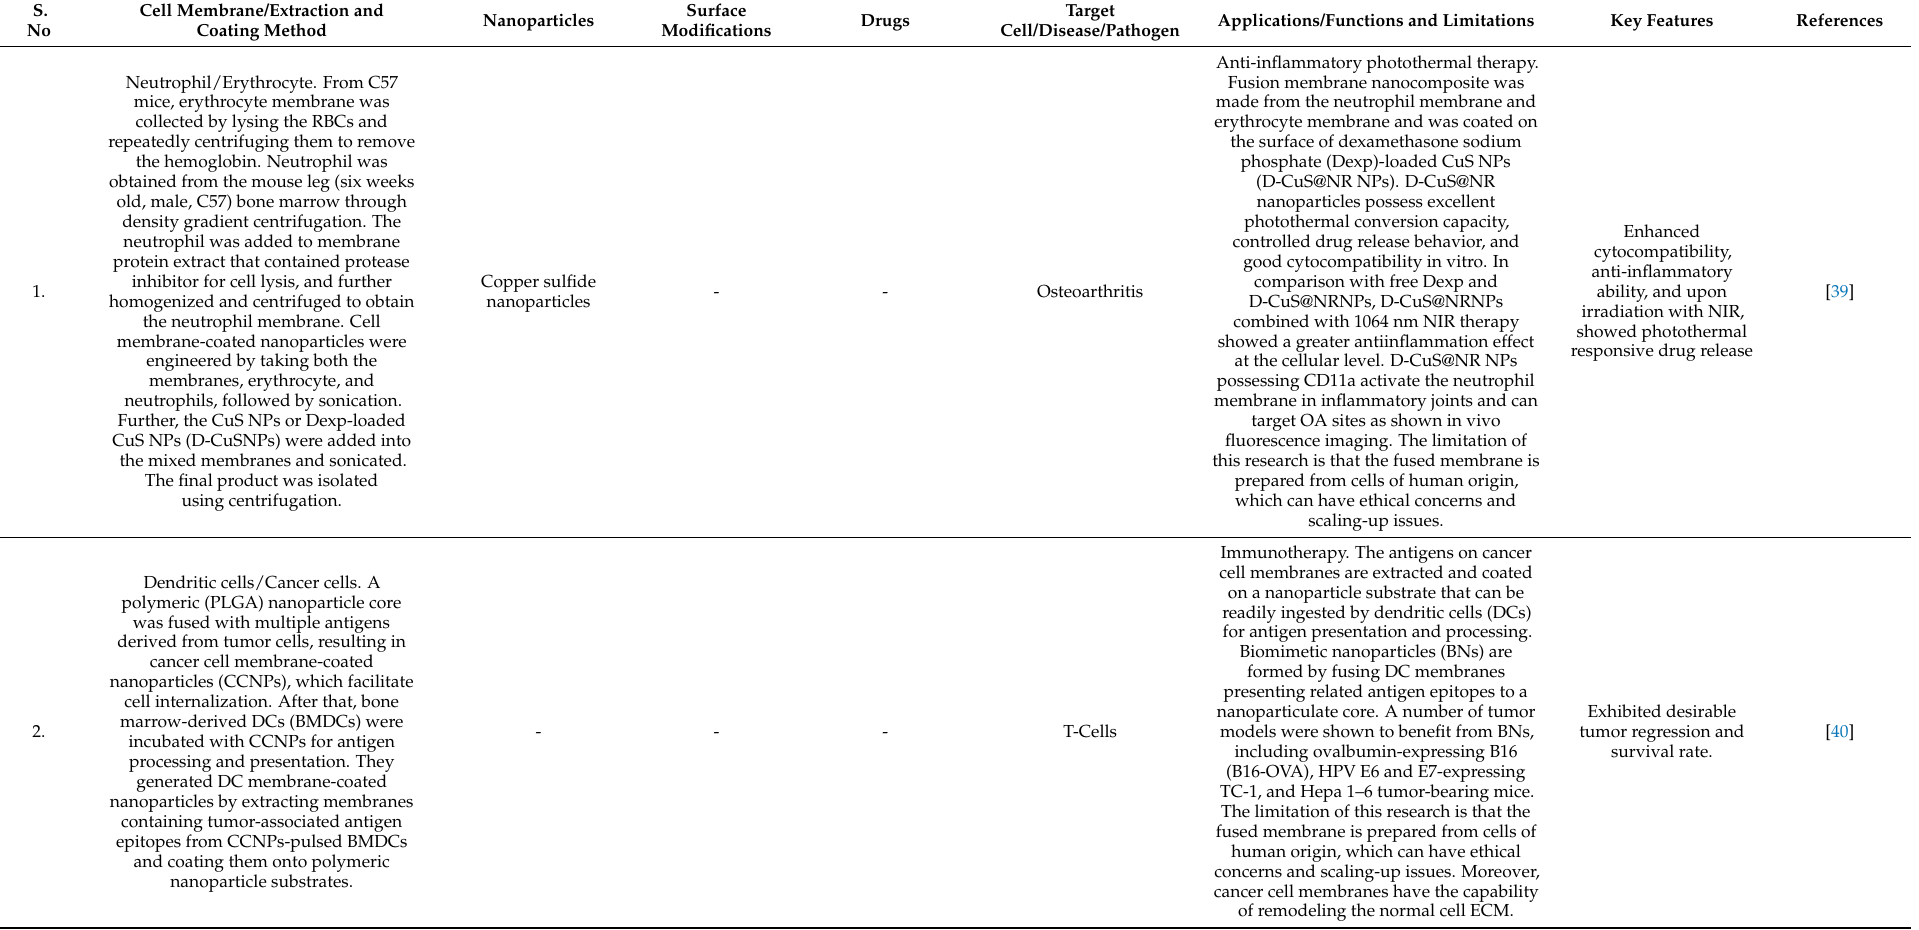
Table 2. Recent Advances in Hybrid Nanodecoys for Biomedical